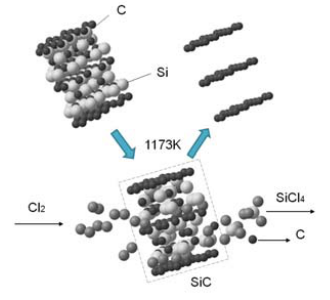
Figure 1. Scheme of the formation of a fragment of the silicon carbide (SiC-AC) carbon adsorbent via thermochemical leaching of Si atoms from silicon carbide.